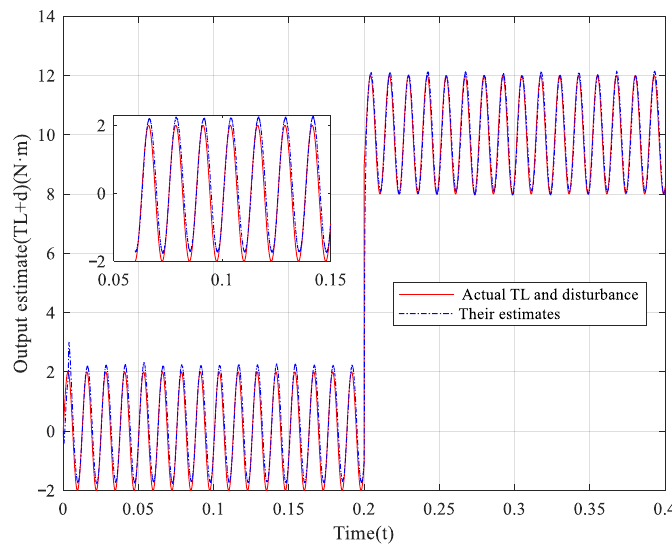
Figure 5. The actual load and disturbance with their estimates in high-speed condition.